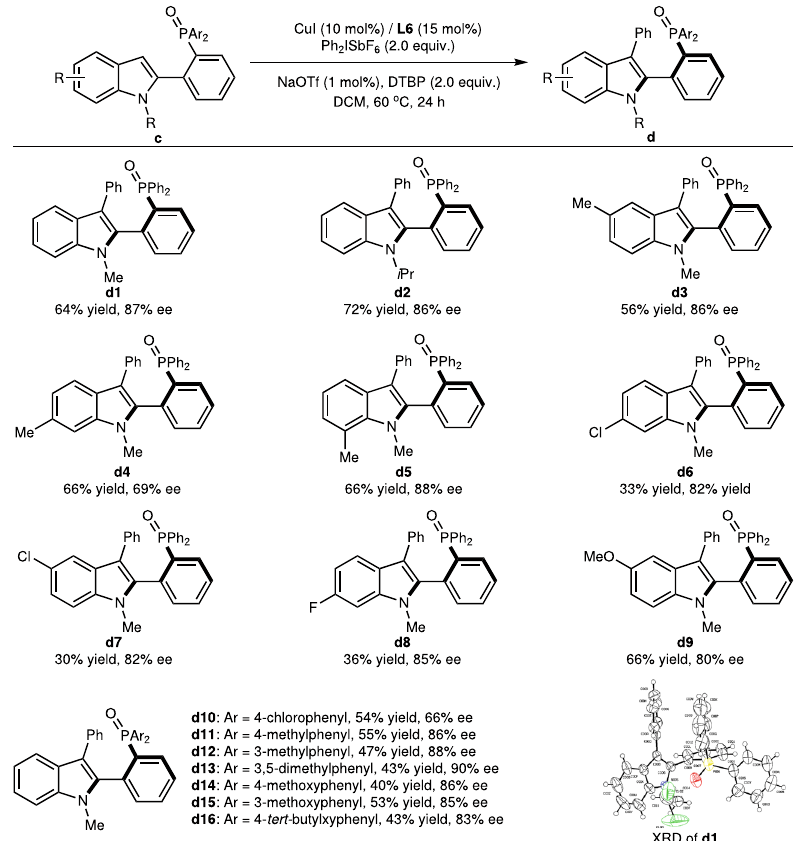
Fig. 4 | Substrate scope with diphenylphosphine oxide indoles. Reaction conditions unless otherwise noted: c (0.10mmol), Ph 2 ISbF 6 (0.2mmol), CuI (0.01mmol), L6 (0.015mmol),NaOTf(0.001mmol),DTBP(0.2mmol),DCM(2mL)inasealedtubeat60°Cfor24h.DTBP2,6-di- tert